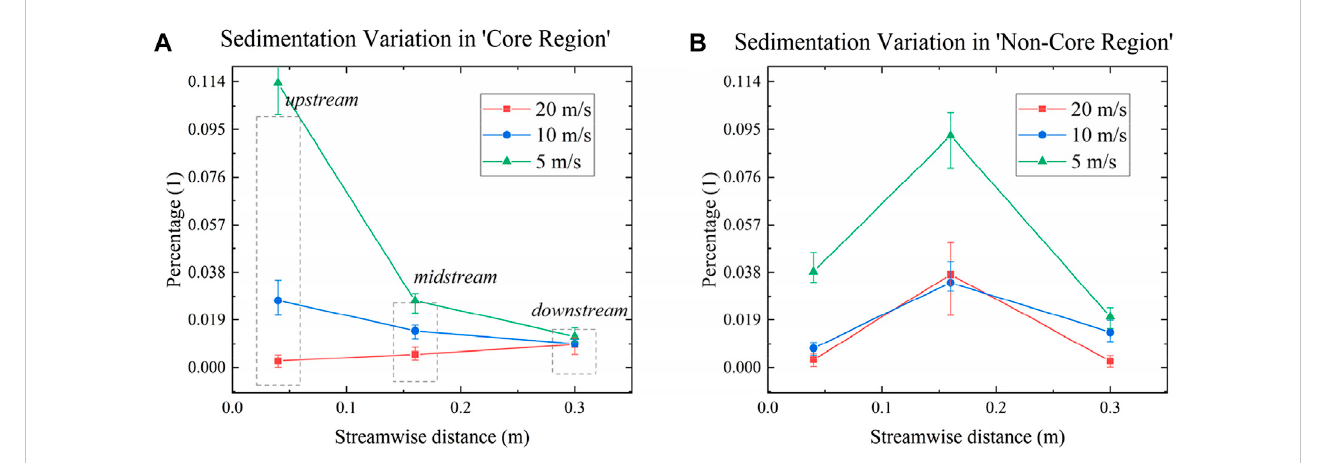
FIGURE 3 Sedimentation percentage from the overall invasion in the core region (A) , and non-core region (B)